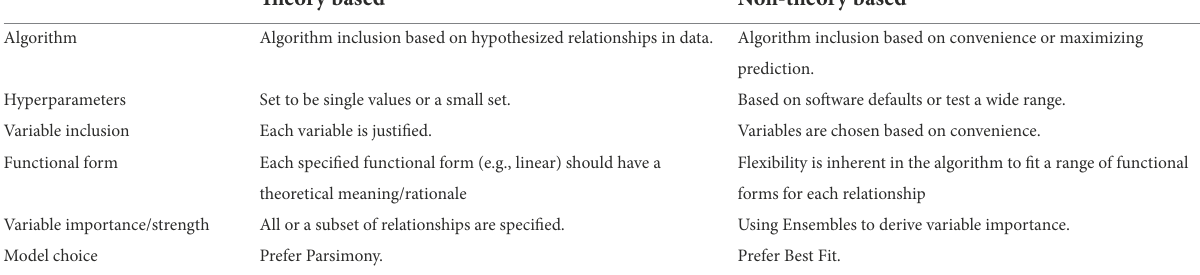
TABLE 1 Decomposition of multiple study components as to whether the decisions are theory based or non-theory based. Theory based Algorithm inclusion based on hypothesized relationships in data. Algorithm inclusion based on convenience or